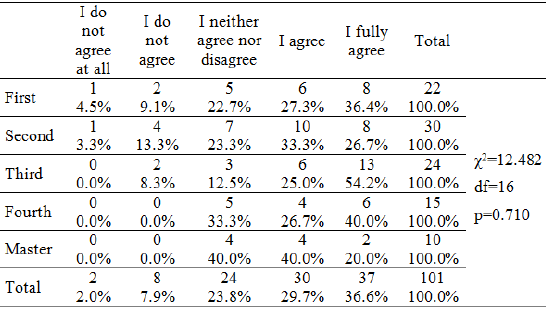
Table 4. Students’ attitude on respecting different religions, by year of studies